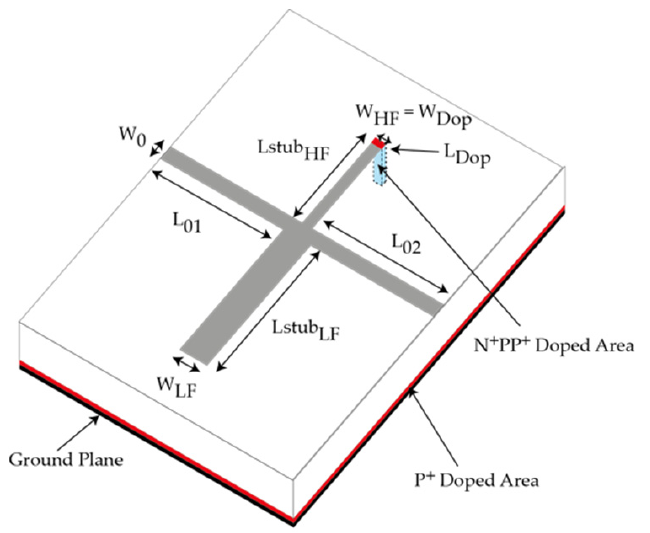
Figure 4. 3-D diagram of the switchable DBR 1 demonstrator. Table 1. Dimensions of Switchable DBR 1 .